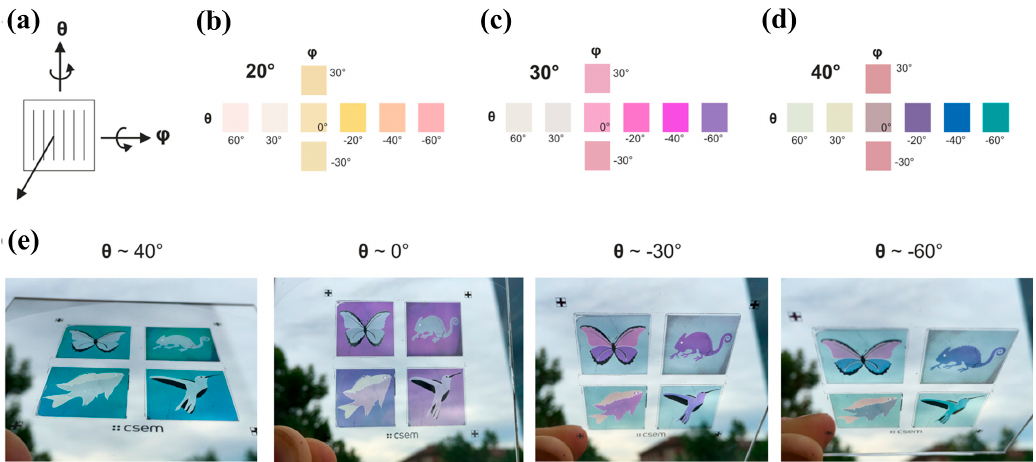
Figure 7. ( a ) Sketch illustration showing sample orientation and two rotating directions ( θ and φ ); ( b – d ) Measured colors of the samples for different evaporation angles and different viewing angles θ and φ defined in sketch ( a ); Note that colors mainly appear at negative angles θ . ( e ) Glass substrates with 4 different sample areas (2 cm × 2 cm) created by the evaporation angles 20°, 30°, and 40°. Note that images were taken in front of a cloudy sky and with unpolarized light. All figures are adapted from reference